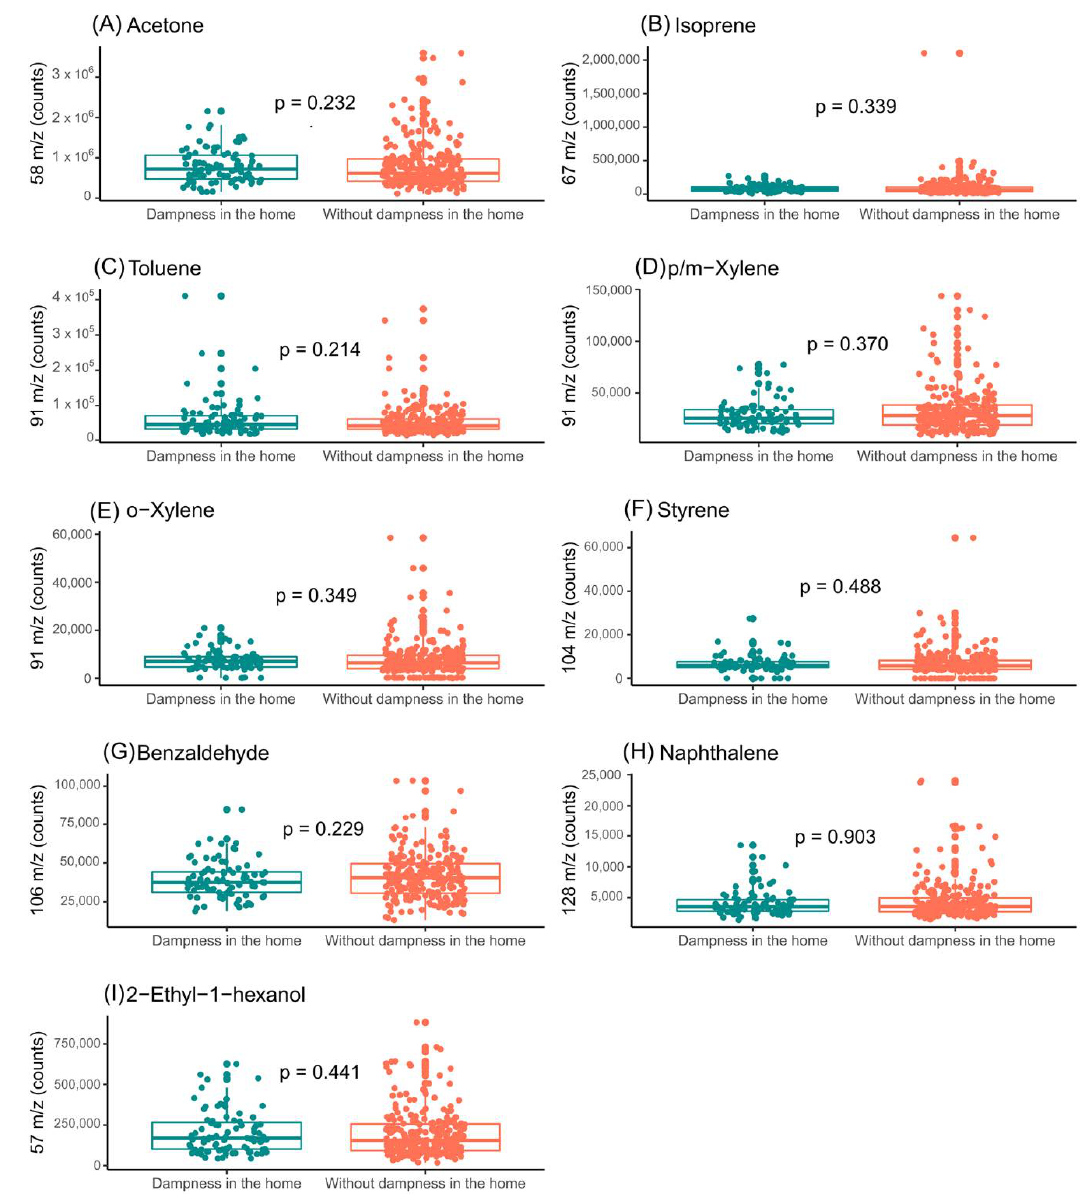
Figure 4. Assessment of influence of indoor-dampness exposure on the levels of the features selected in exhaled breath from children. ( A ) Impact of indoor-dampness exposure on levels of acetone ( m/z = 58); ( B ) Impact of indoor-dampness exposure on levels of isoprene ( m/z = 67); ( C ) impact of indoor-dampness exposure on levels of toluene ( m/z = 91); ( D ) impact of indoor-dampness exposure on levels of p/m-xylene ( m/z = 91); ( E ) impact of indoor-dampness exposure on levels of o-xylene ( m/z = 91); ( F ) impact of indoor-dampness exposure on levels of styrene ( m/z = 104); ( G ) impact of indoor-dampness exposure on levels of benzaldehyde ( m/z = 106); ( H ) impact of indoor-dampness exposure on levels of naphthalene ( m/z = 128); and ( I ) impact of indoor-dampness exposure on levels of 2- ethyl-1-hexanol ( m/z = 57) in exhaled breath of children.